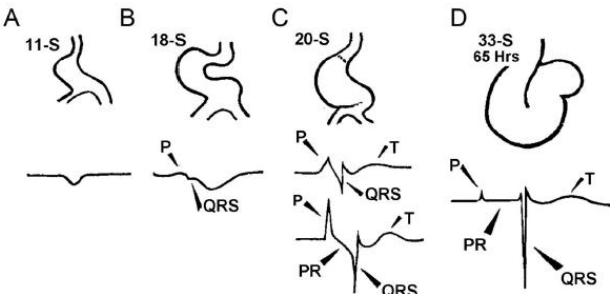
Figure 2. Schematic of chicken heart development and corresponding electrocardiograms at somite stages shown. ( A ) Somite Stage 11 (11-S); ( B ) 18-S; ( C ) 20-S; and ( D ) 33-S (Reproduced with permission from [3]).